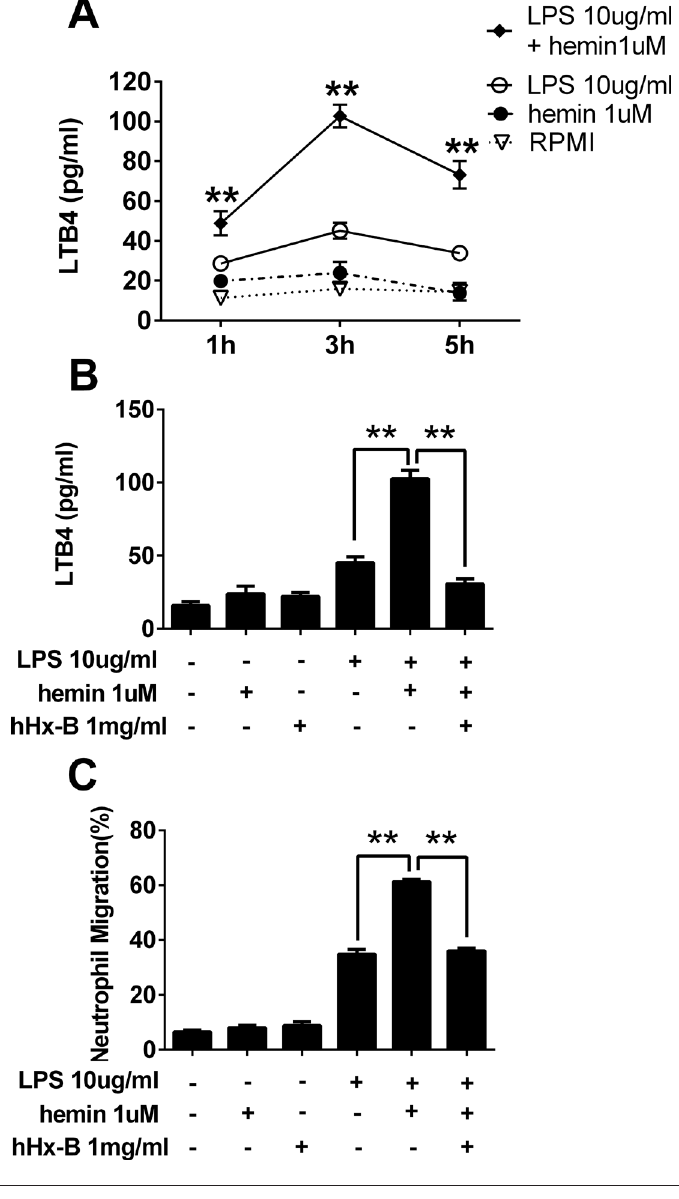
Figure 7. LPS and hemin synergistically induce the production of LTB4 from human mono- cytes and Hx blocks this synergy by decreasing LTB4 levels and suppresses chemotaxis of neutrophils. (A) Human monocytes were incubated with LPS (10 μ g/mL) in the presence or absence of hemin (1 μ mol/L) for 1, 3 and 5 h. LTB4 concentrations in the supernatants were measured and compared between the cultures with LPS only and with LPS and hemin. (B) Human monocytes were incubated with LPS (10 μ g/mL) and with or without hemin (1 μ mol/L) in the absence or presence of hHx-B (1 mg/mL) for 3 h. LTB4 concentra- tions were measured and compared between the cultures with and without Hx. (C) The supernatants collected from human monocyte cultures at 3 h were loaded to the bot- tom microplate well of the transmigration system in chemotaxis assay. The percentage of neutrophils migrated to the bottom wells over the total cells loaded to the top of the transwells were calculated and compared between the cultures with and without hHx-B. The results are representative of three independent experiments and presented as the mean ± SE. **P < 0.01 LPS with hemin versus LPS